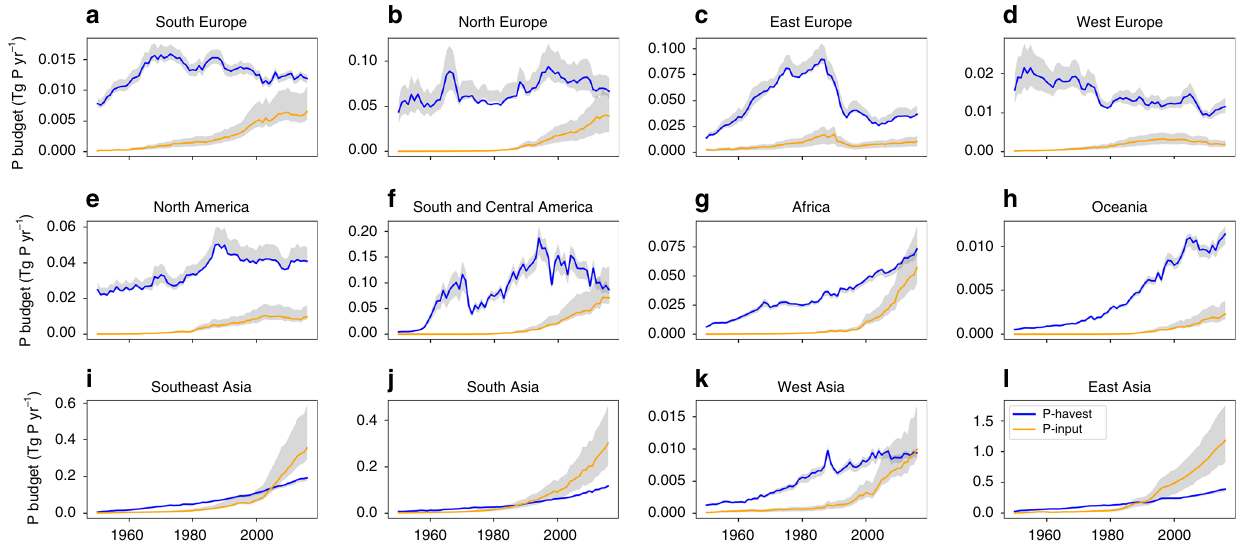
Fig. 3 Continental-scale fi shery phosphorus balance from 1950 to 2016. Continent designation is based on FishStatJ version 3.04.6 25 and details are provided in Supplementary Table 2. Gray shading indicates the interquartile ranges (IQR, the 75th and 25th percentiles). Units are Tg P yr − 1 . Note that the Soviet Union is assigned as part of East Europe before its collapse and countries are assigned into different continents according to their geo-location after the collapse. Source data are provided as a Source Data fi Thailand 2%. Reduction in P-harvest was the main contributor to